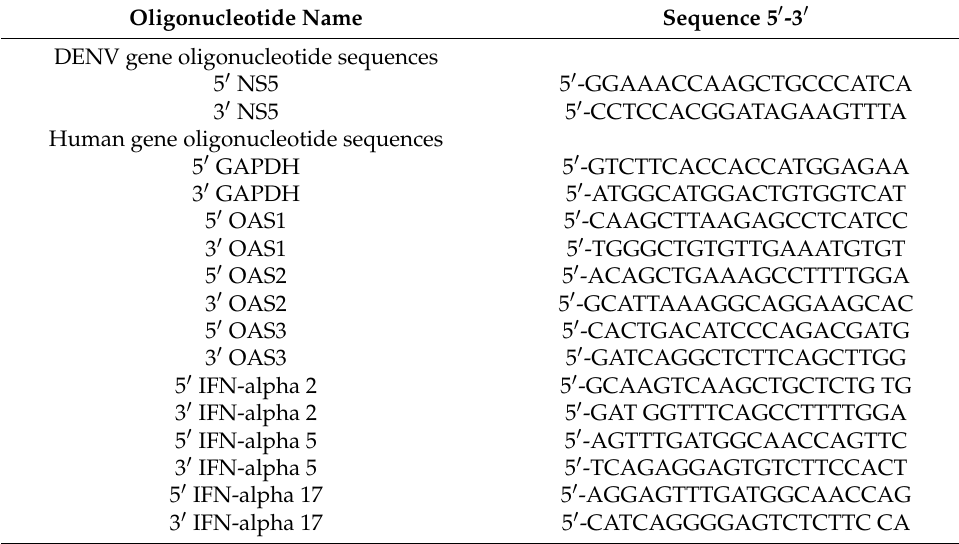
Table 1. Oligonucleotide sequences for real-time RT-PCR. Oligonucleotide